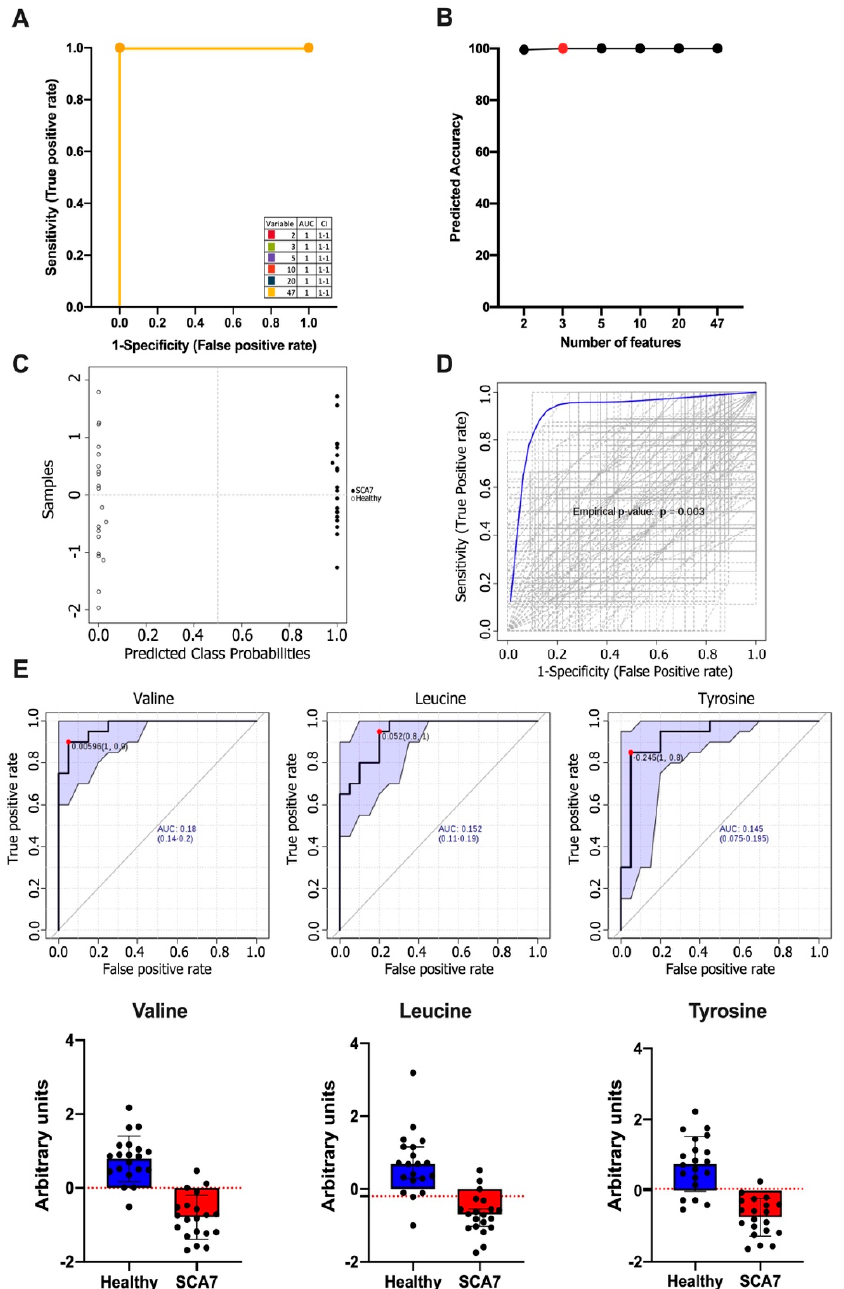
Figure 2. ( A ) ROC curves for all models are based on their average performance; ( B ) Predictive accuracy of biomarker models with an increasing number of features. The most accurate biomarker model is highlighted with a red dot; ( C ) Predicted class probabilities for all samples (healthy controls (open circle) and SCA7 patients (filled circle)) using the created biomarker model. Due to balanced subsampling, the classification boundary is at the center (x = 0.5, dotted line); ( D ) Permutations tests using the area under the ROC curve or the predictive accuracy of the model as a measure of performance. The plot shows the AUC of all permutations, highlighting the actual observed AUC in blue, along with showing the empirical p -value ( p = 0.003); ( E ) ROC curves of Valine, Tyrosine, and Leucine. The sensitivity is plotted on the y-axis and the specificity on the x-axis. The Area Under the Curve (AUC) is in blue. The graphs under ROC curves correspond to a boxplot of the two experimental groups within the dataset. ROC analysis calculated by FRPmax (False positive rate).